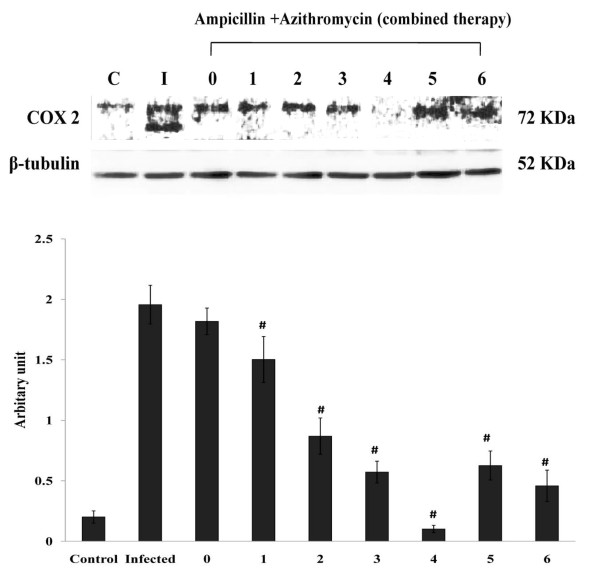
Expression of COX-2 after treatment with ampicillin in combination with azithromycin in lung tissue. Expression of COX-2 in lung tissue was measured in terms of fold change over S. pneumoniae infected untreated control. Highest level of COX-2 was found at 18 h post infection. Gradual reduction in COX-2 level was visible after treatment with ampicllin in combination with azithromycin with the decrease being most prominent at 4th hour post antibiotic treatment. S. pneumoniae AMRI SP -1 infected untreated control group versus S. pneumoniae AMRI SP-1 + ampicillin + azithromycin treated group (P < 0.01 significant decrease with respect to SP infected untreated control at 1-3 h post antibiotic treatment).